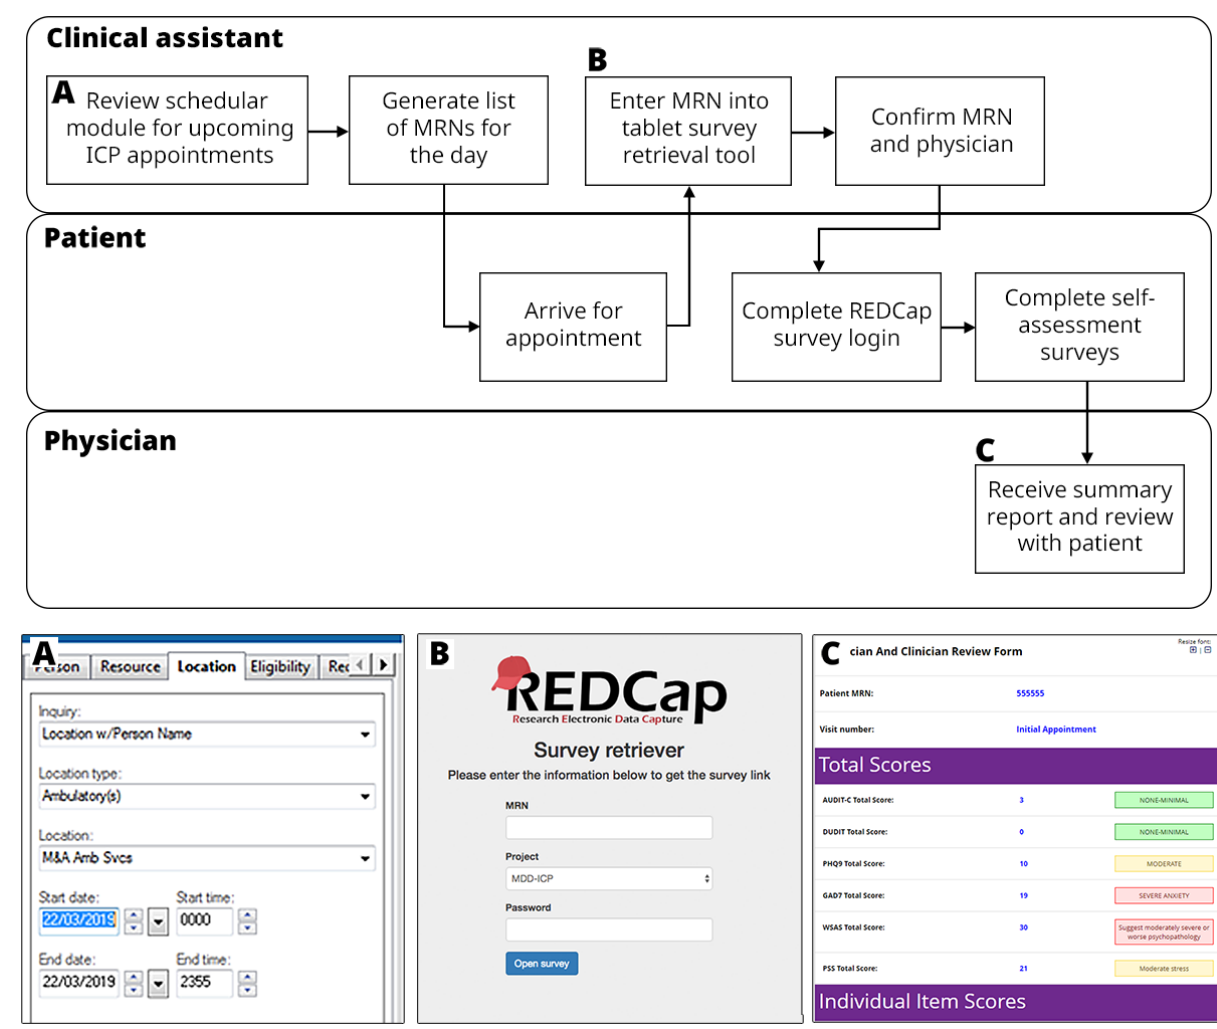
Figure 1. Clinical REDCap workflow and example screens for a typical follow-up appointment. (A) Cerner scheduler view. (B) Custom survey retriever tool used as a tablet homepage. (C) Summary report built as a REDCap survey. ICP: integrated care pathways; MRN: medical record number; REDCap: Research Electronic Data